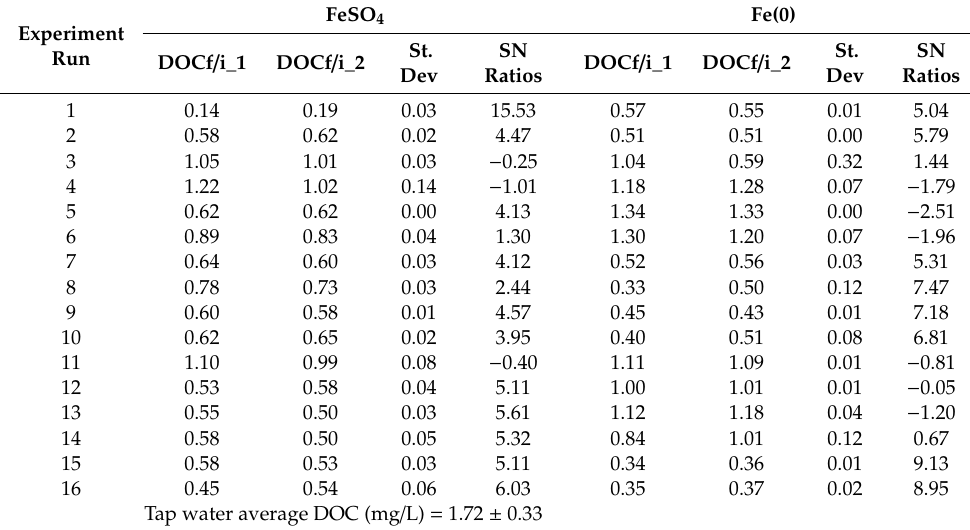
Table 5. Dissolved organic carbon (DOC) removal factor value and signal-to-noise (SN) ratios from each experiment run reaction condition using FeSO 4 and Fe catalyst in the Fenton oxidation process. FeSO 4 Experiment Run